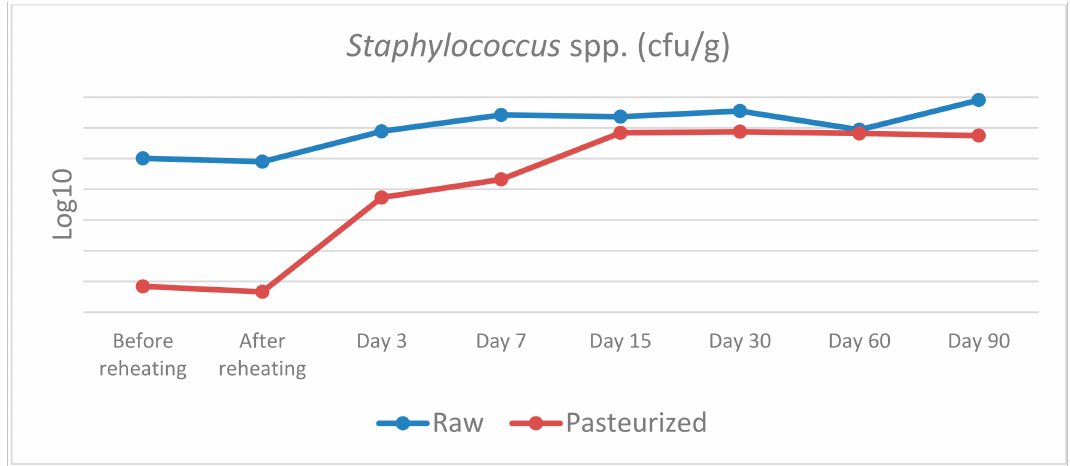
Figure 3. Staphylococcus spp. counts in raw and pasteurized curd and cheese